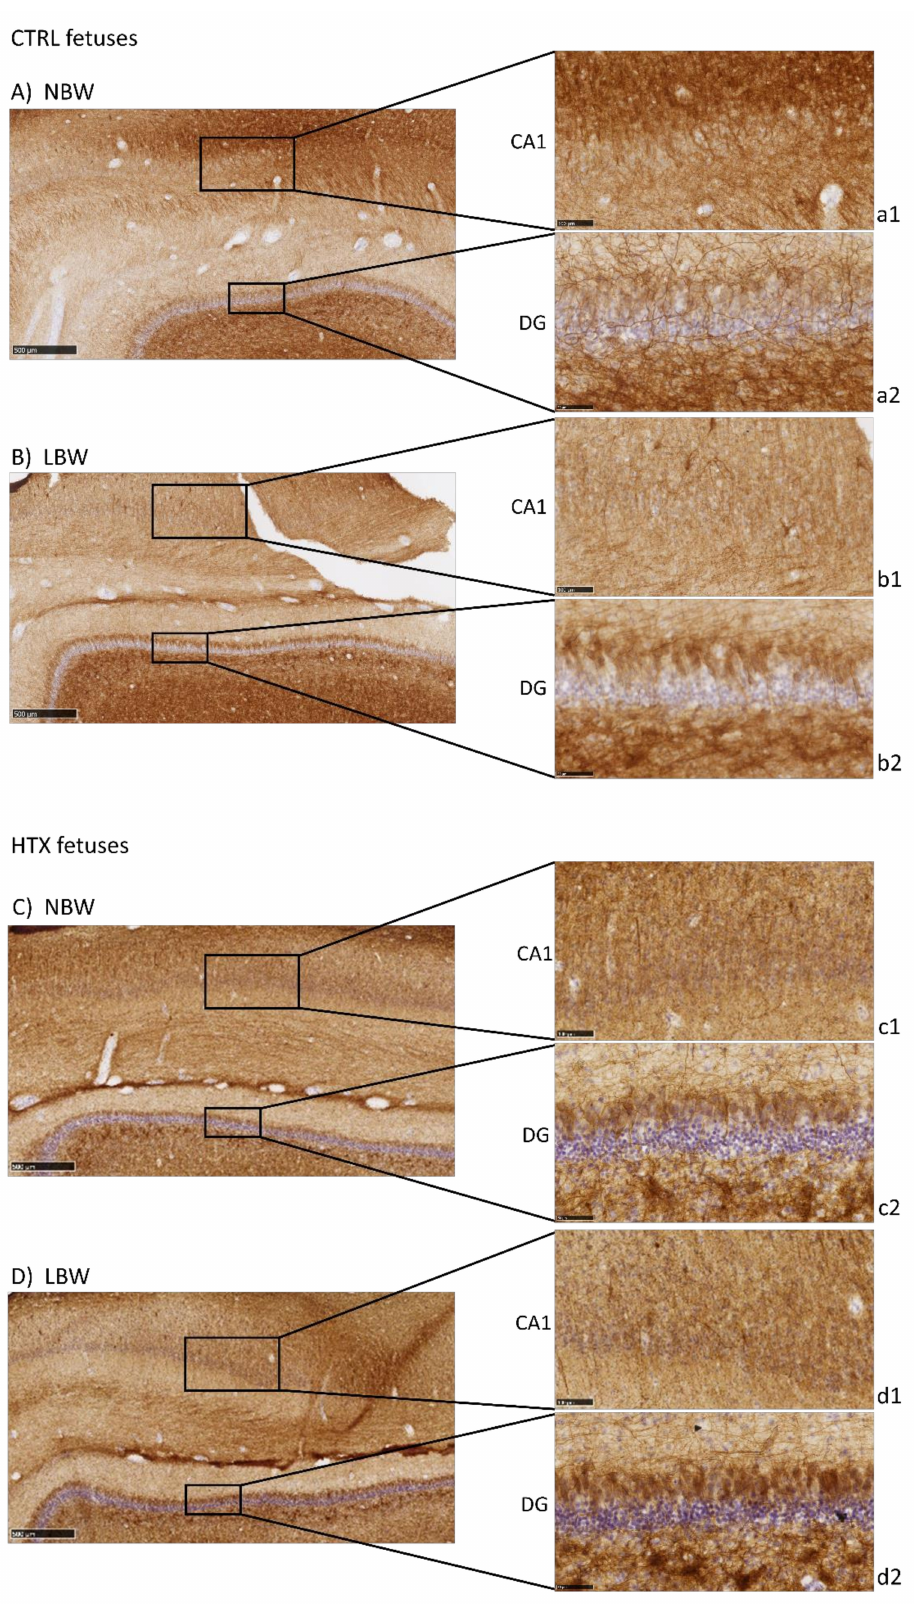
Figure 3. Effect of IUGR on neurofilaments (NFT) immunostaining on the hippocampus of fetuses whose mothers were not HTX-supplemented ( A , B ) or were HTX-supplemented ( C , D ). Panels are magnifications of the CA1 ( a1 – d1 ) and DG ( a2 – d2 ) areas shown using black boxes. Scale bars: 500 µ m ( A – D ), 100 µ m ( a1 – d1 ), and 50 µ m ( a2 – d2